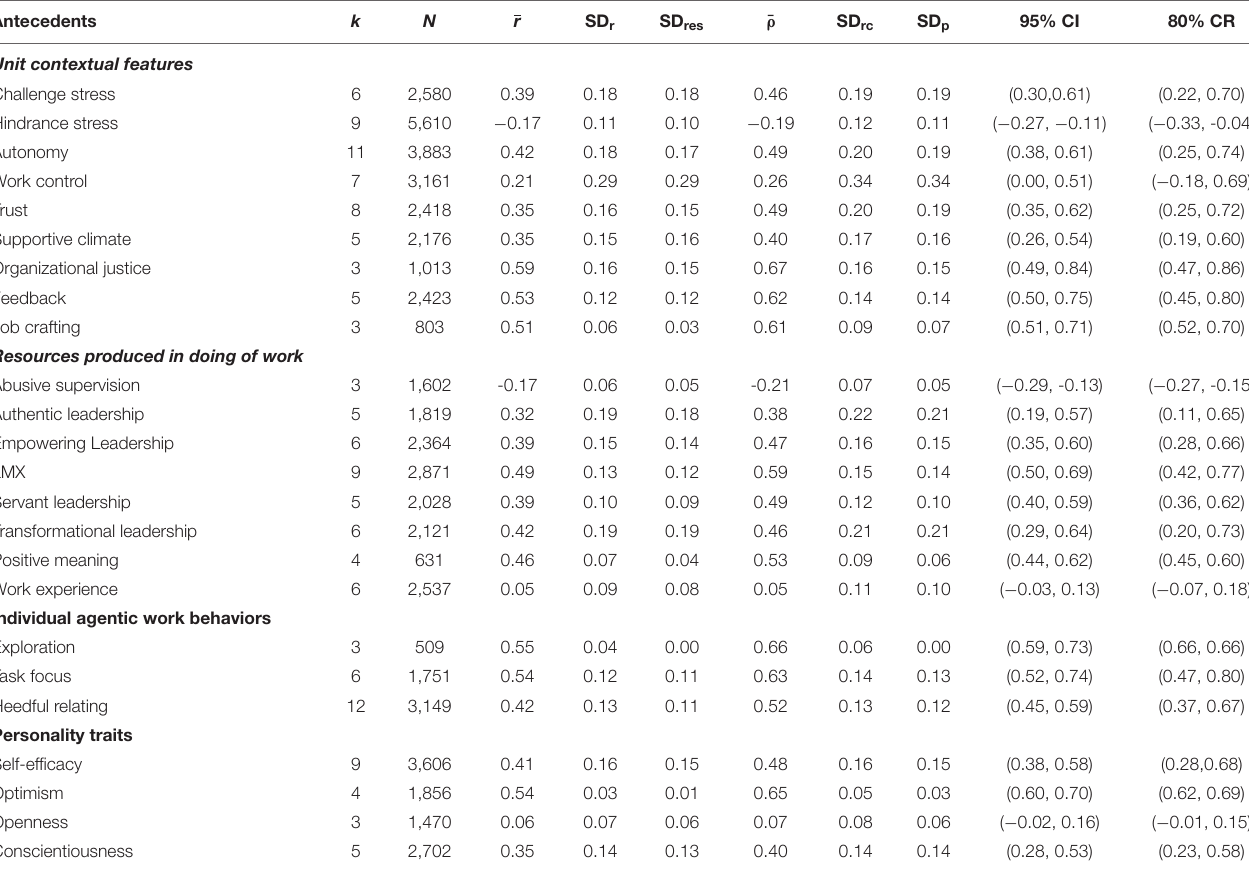
TABLE 5 | Meta-analysis of relationships between thriving at work and its antecedents.